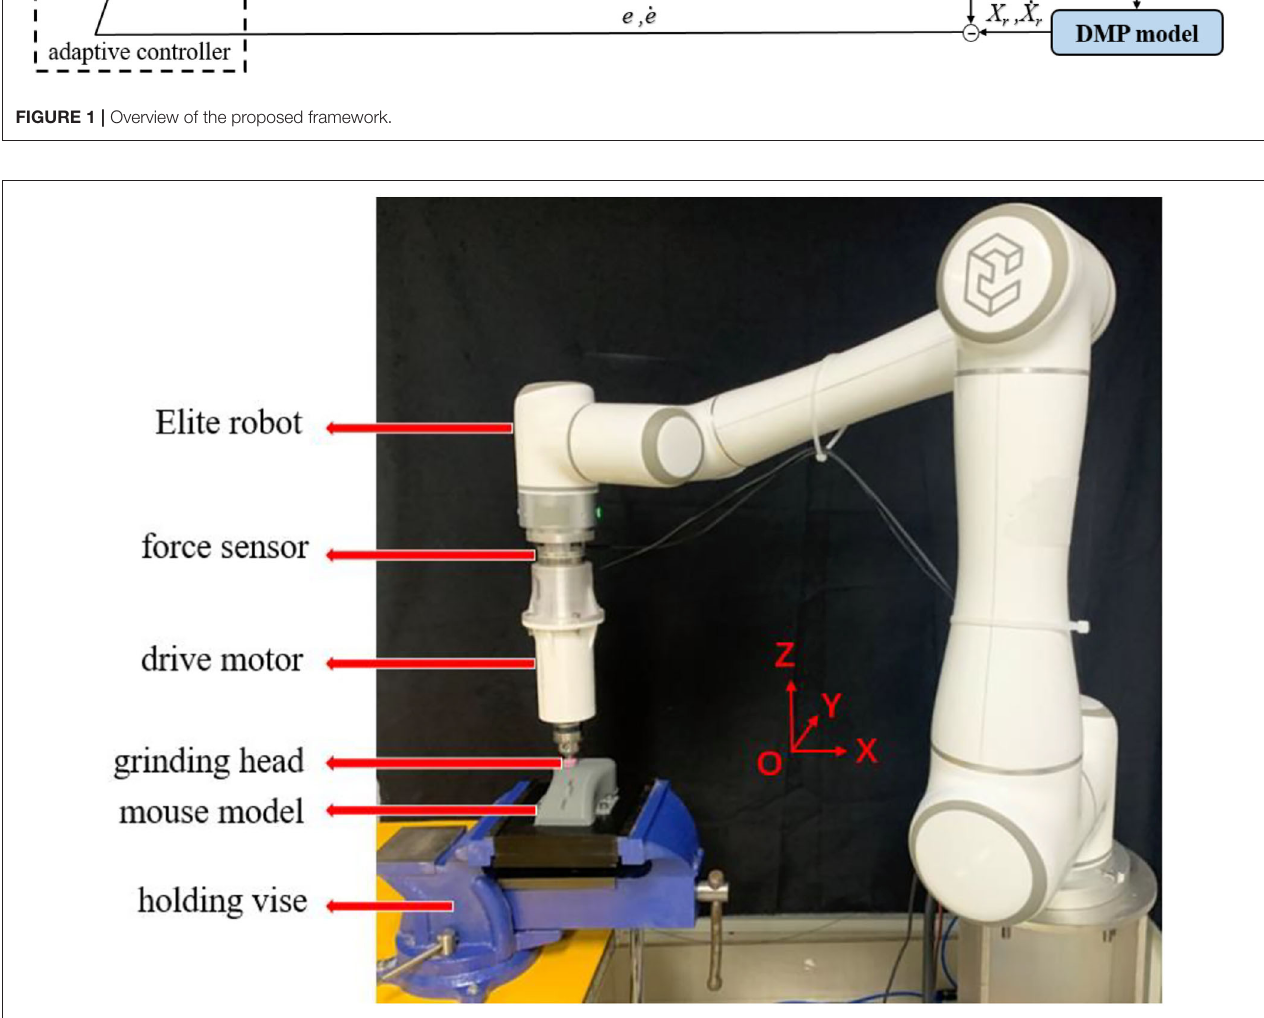
FIGURE 2 | Grinding experiment platform based on Elite